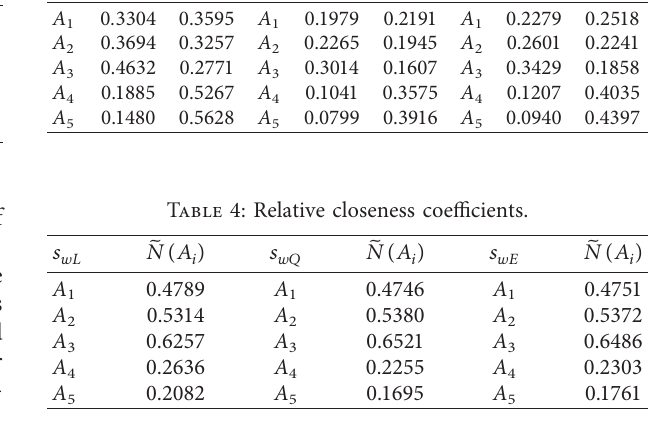
Table 2: Belief-plausible decision matrix. Criteria evaluation Alternatives